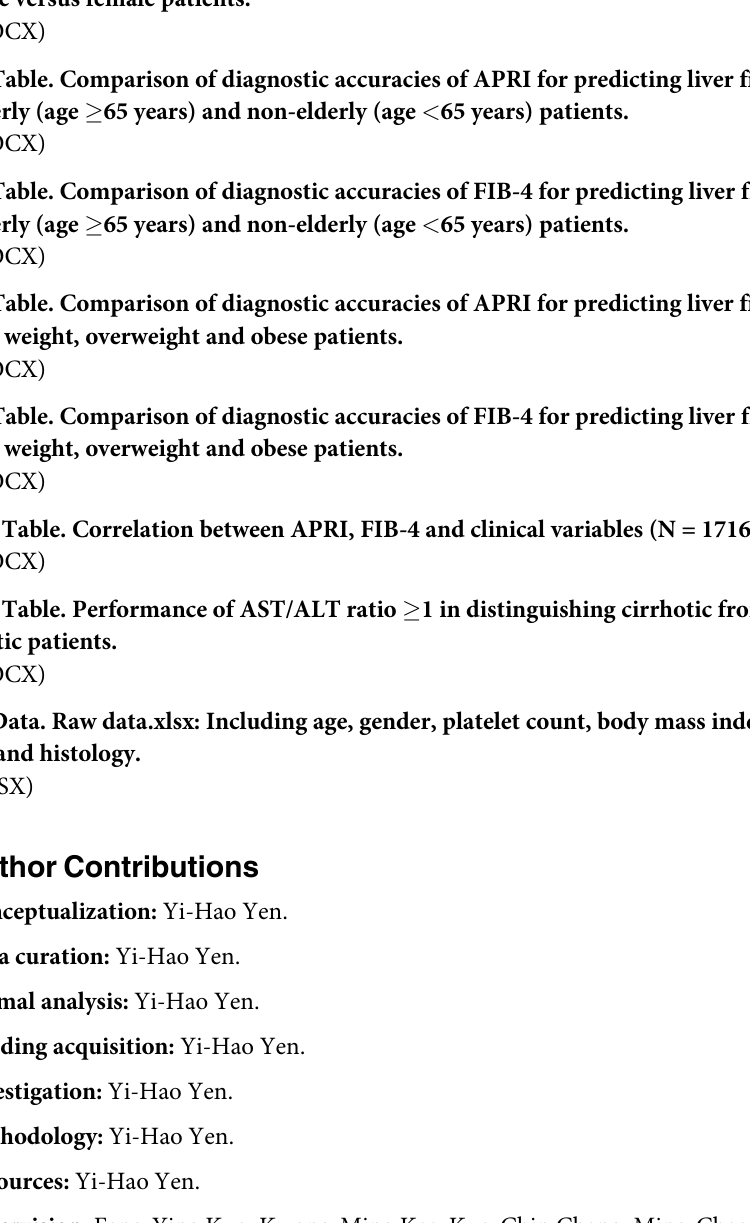
S3 Table. Comparison of demographic, laboratory and histological characteristics in patients with normal weight, overweight and obese. S4 Table. Comparison of diagnostic accuracies of APRI for predicting liver fibrosis in male versus female patients. S5 Table. Comparison of diagnostic accuracies of FIB-4 for predicting liver fibrosis in male versus female patients. S6 Table. Comparison of diagnostic accuracies of APRI for predicting liver fibrosis in